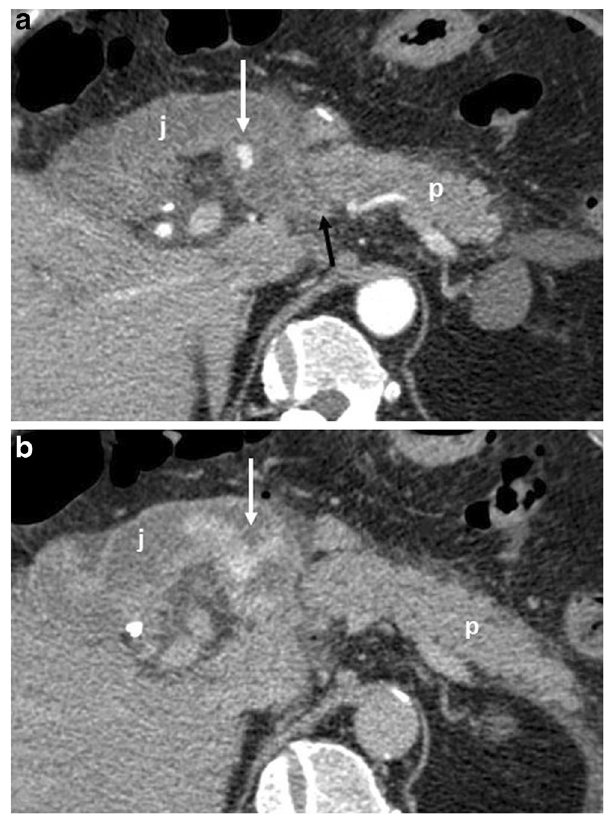
Fig. 18 a , b Axial CT curvilinear reconstructions show an active extravasation in the arterial phase (white arrow in a ) within the lumen of the jejunal anastomotic loop (j). Bleeding becomes more evident in the late phase (white arrow in b ). The pancreatic stump is seen (p)